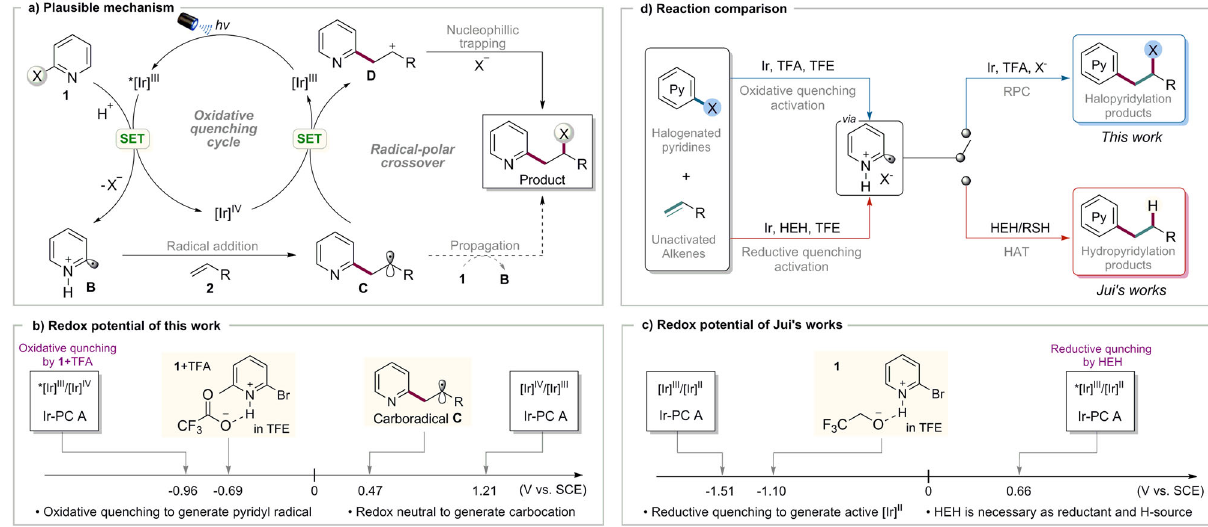
Fig. 5 Proposed mechanism and comparison. a Plausible mechanism. b Redox potential of this work. c Redox potential of Jui ’ s works. d Reaction